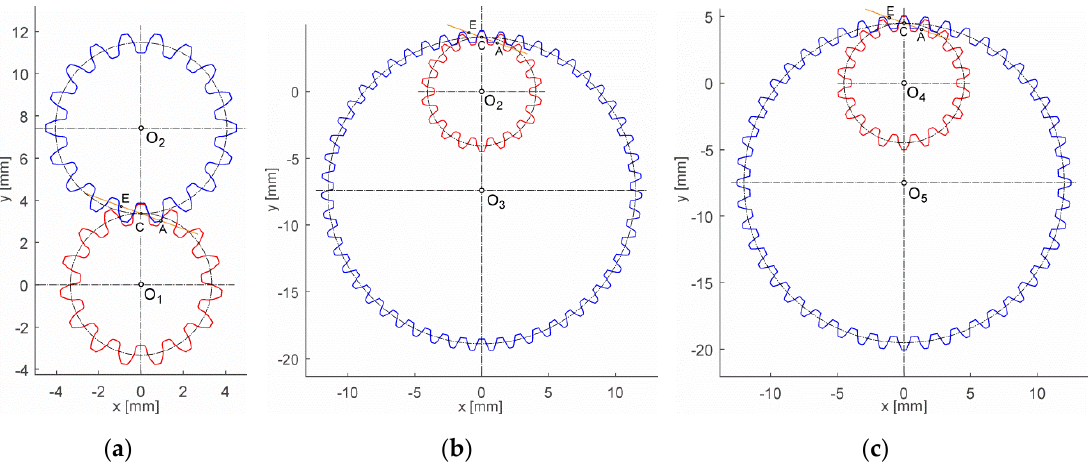
Figure 6. Geometric models of the gear pairs with involute teeth flanks: ( a ) gear pair 1-2, ( b ) gear pair 2-3, and ( c ) gear pair 4-5.